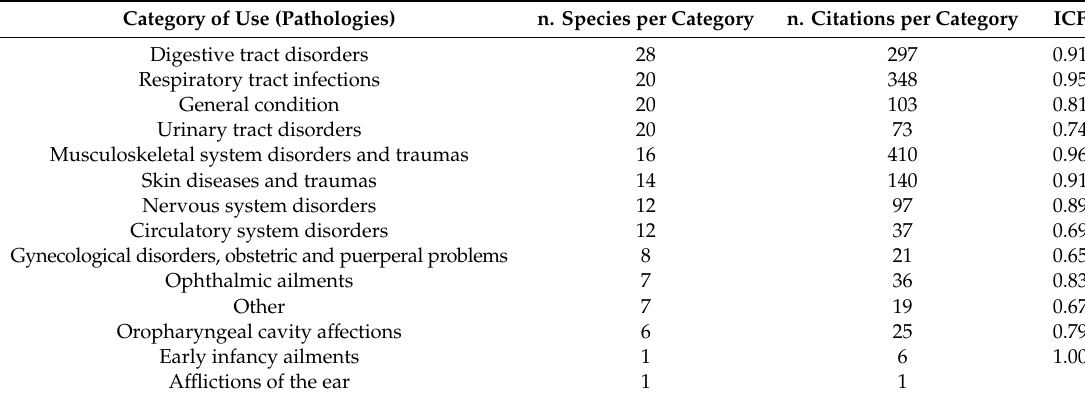
Table 2. Categories of use (pathologies treated in